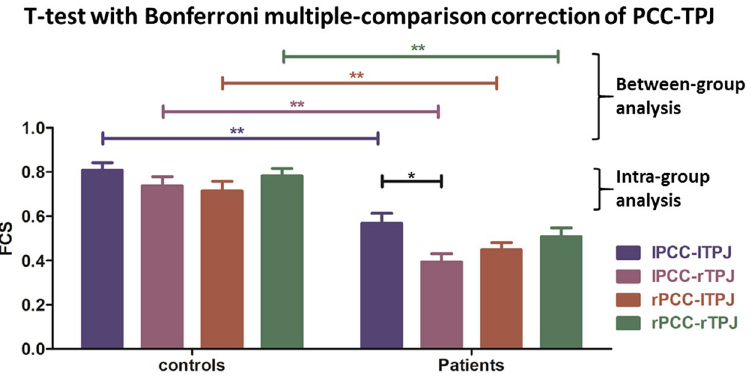
Figure 2. The bars represent the relative magnitudes of the FCSs (mean + / − SE). The general linear model (univariate) test showed that there were differences between the controls and patients (F = 99.626; P < 0.01), and the T-test with Bonferroni multiple-comparison correction demonstrated that (1) for the between-group analysis, both the intra- and cross-hemispherical FCSs of the patients decreased compared with controls; (2) for the intra-group analysis, a difference was detected between the left intra-hemispheric (lPCC-lTPJ) FCS and the cross-hemispheric (lPCC-rTPJ) FCS (F = 3.094; P = 0.011, corrected) for the patient group, whereas no significant difference among the PCC-TPJ patterns was observed in the control group (F = 1.215; P = 0.310, corrected). ** α = 0.01; * α = 0.05.